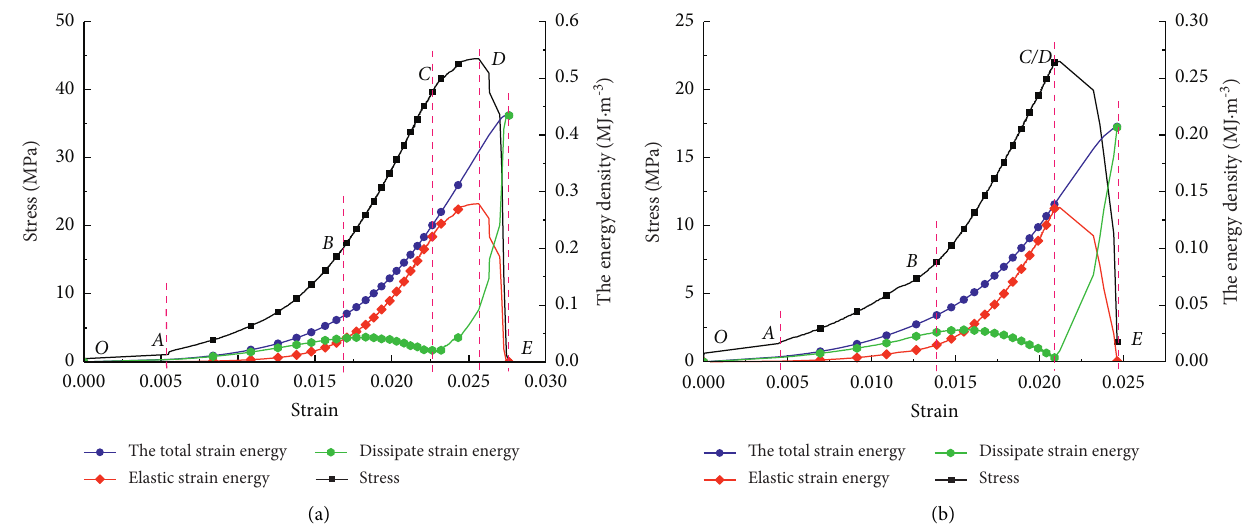
Figure 7: Relationship between stress, energy, and strain of rock samples under uniaxial conditions of different water-bearing states. (a) Energy density curves of rock samples under typical dry conditions. (b) Energy density curves of rock samples under typical saturated conditions.